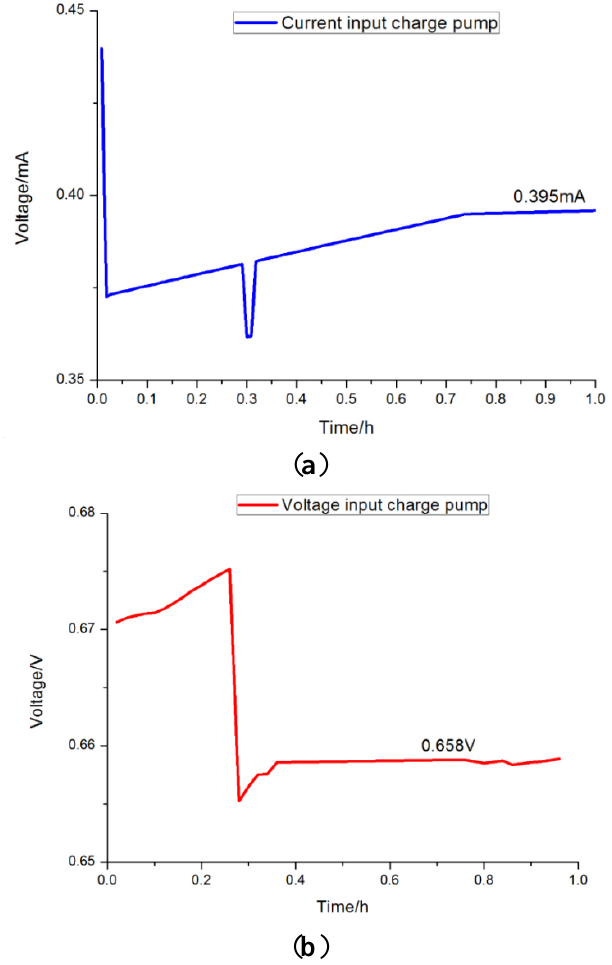
Figure 11. Voltage and current input through the charge pump. ( a ) Current input of charge pump; ( b ) Voltage input of charge pump. .